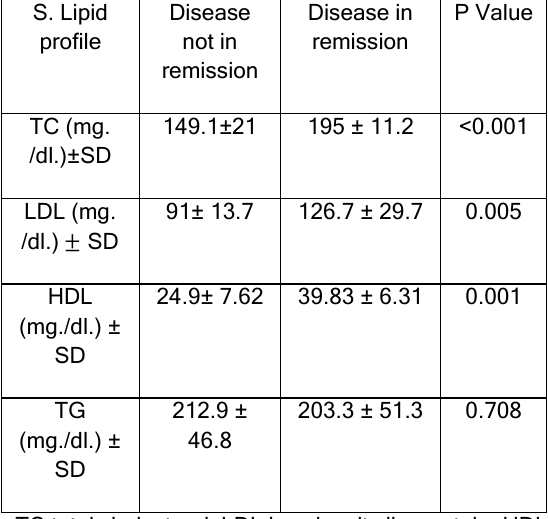
Table-. 2 -correlation of serum lipids with the disease activity in ALL